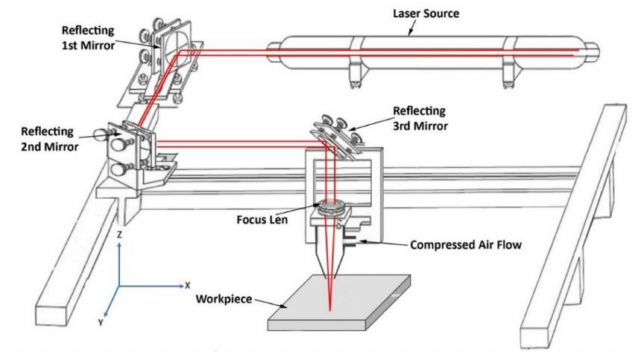
Figure 1. Schematic diagram of the laser engraving system.